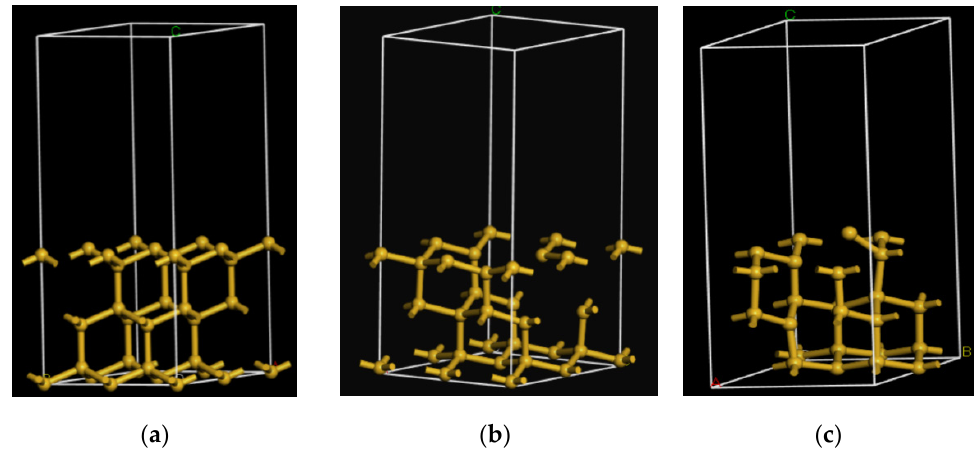
Figure 1. Structural models of ( a ) Defect-free; ( b ) Vacancy; ( c ) Lattice dislocation.